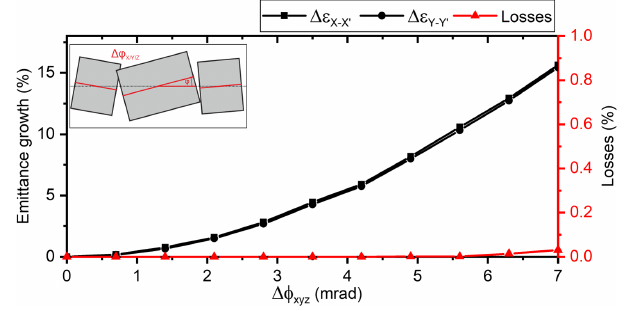
linac.FIG. 28. The rms emittance growth and average losses for quadrupole singlet rotation around all three axes along the